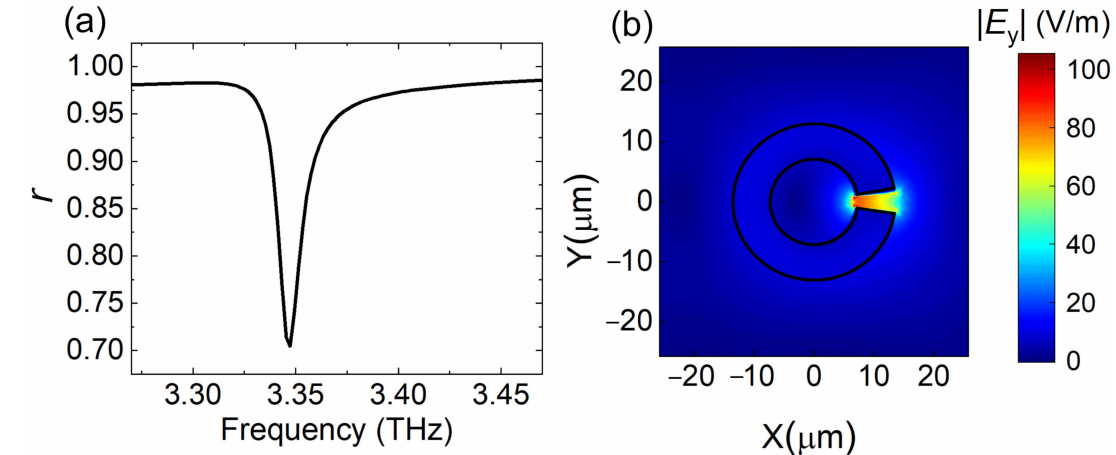
Figure 6. ( a ) Reflection amplitude for graphene-dielectric reflective metasurface as a function of frequency without optical pump. ( b ) Electric field distribution for graphene-dielectric reflective metasurface in the xy plane at 3.35 THz ( I = 0 W / mm 2